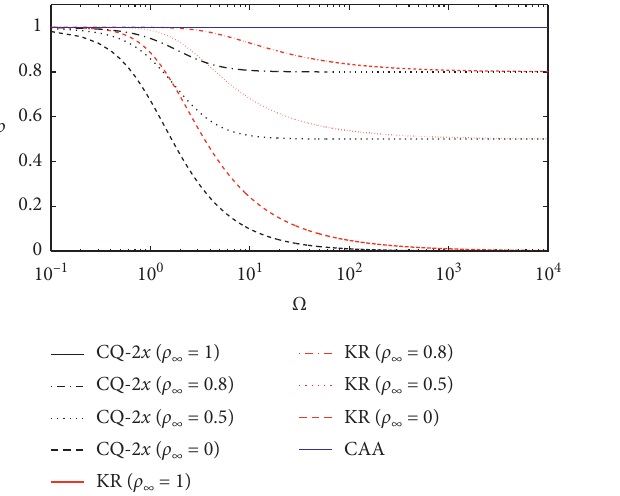
Figure 3: Spectral radius of CQ-2 x when ξ � 0 . Figure 4: Spectral radius of CQ-2 x when ξ � 0 . 05